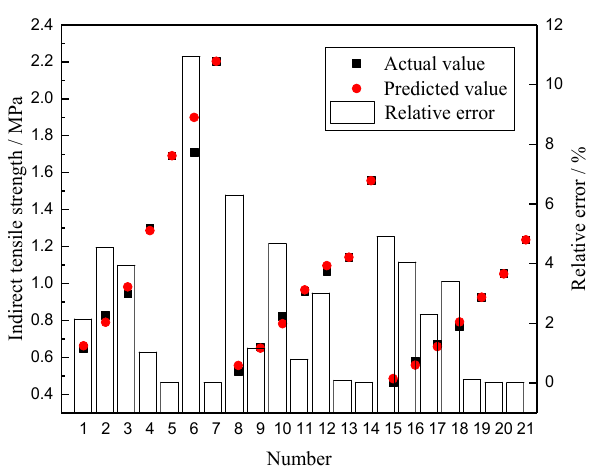
Figure 7. Prediction results of GA-BPNN.